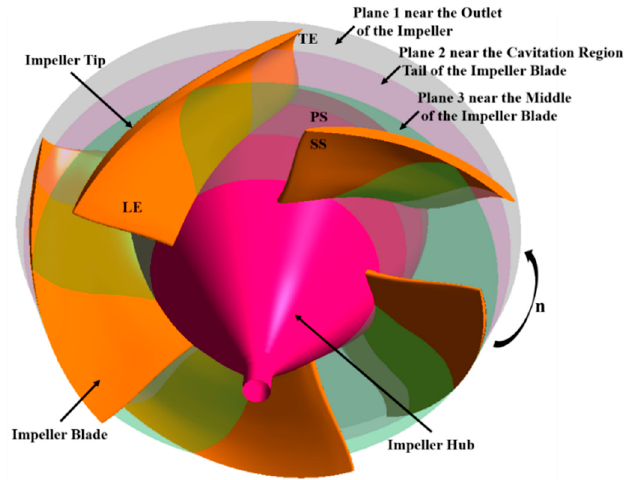
Figure 17. Selection and setting of the density and the pressure contour plane section under the Breakdown Cavitation Condition.